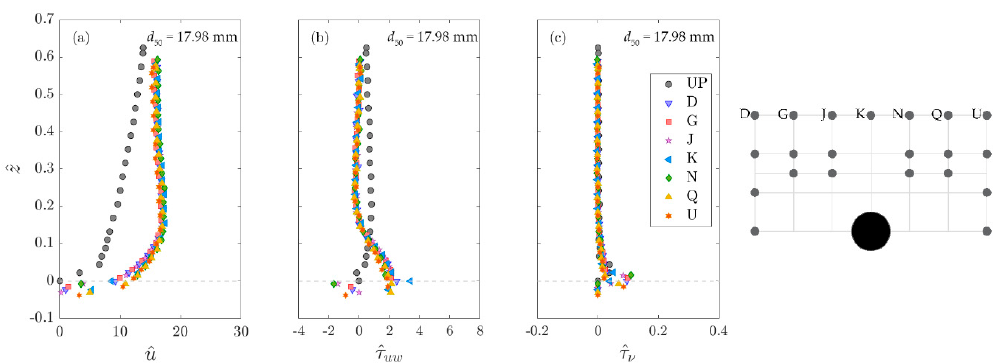
Figure 10. Vertical distributions of ( a ) dimensionless time-averaged velocity, ( b ) dimensionless Reynolds shear stress, and ( c ) dimensionless viscous shear stress at y = 0 in Run 3.